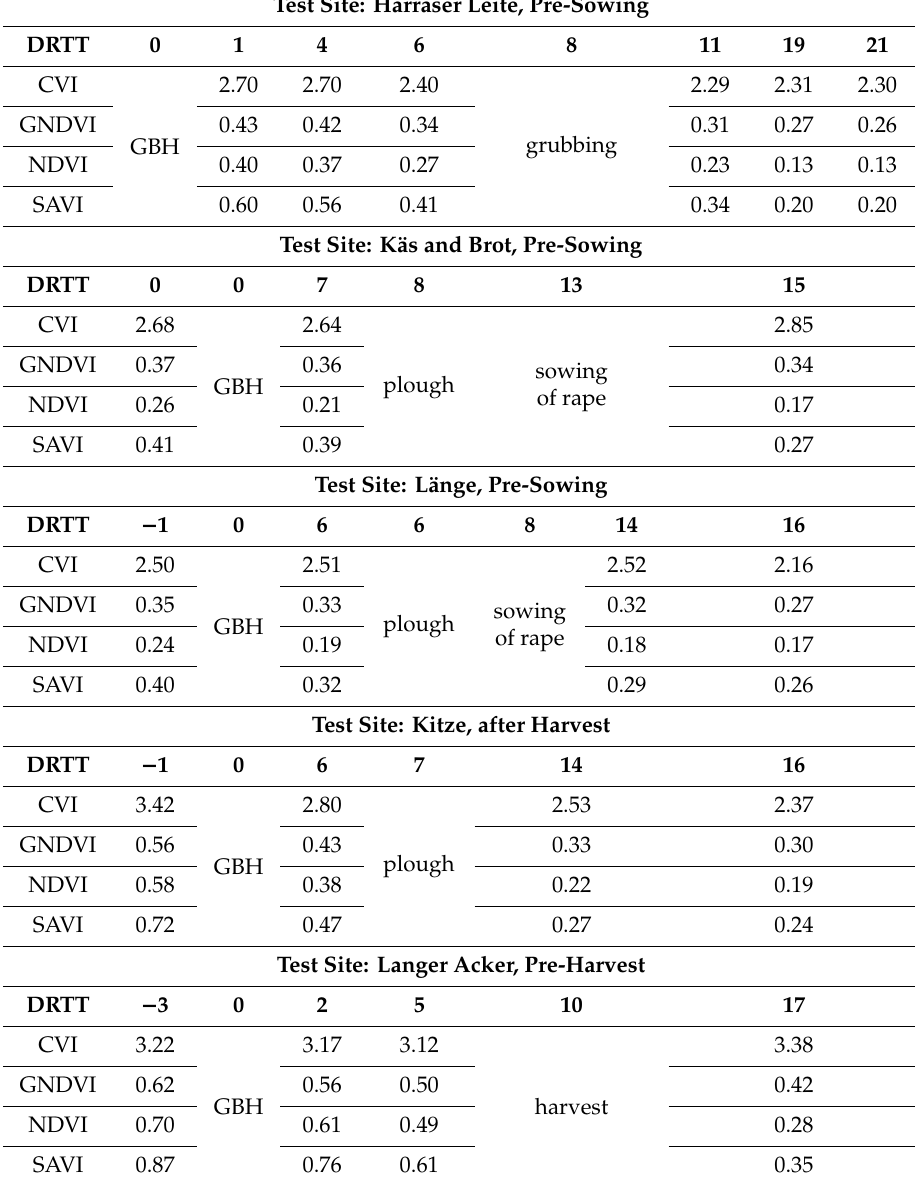
Table 4. Mean values of calculated spectral indices (CVI, GNDVI, NDVI, SAVI) using Sentinel-2 BOA reflectance. The numbers in the table header indicate the temporal shift of the observation day related to GBH treatment (DRTT, numbers in bold). 0 = day of GBH treatment, e.g., − 3 = three days before GBH treatment, 4 = four days after GBH